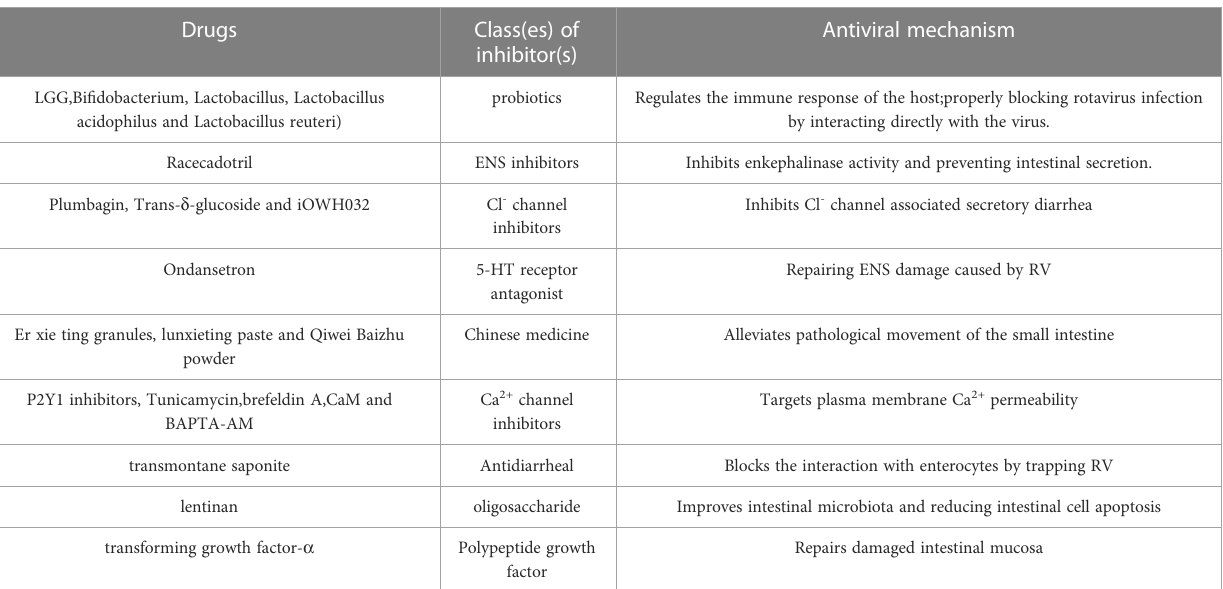
TABLE 2 Drugs increasing intestinal barrier